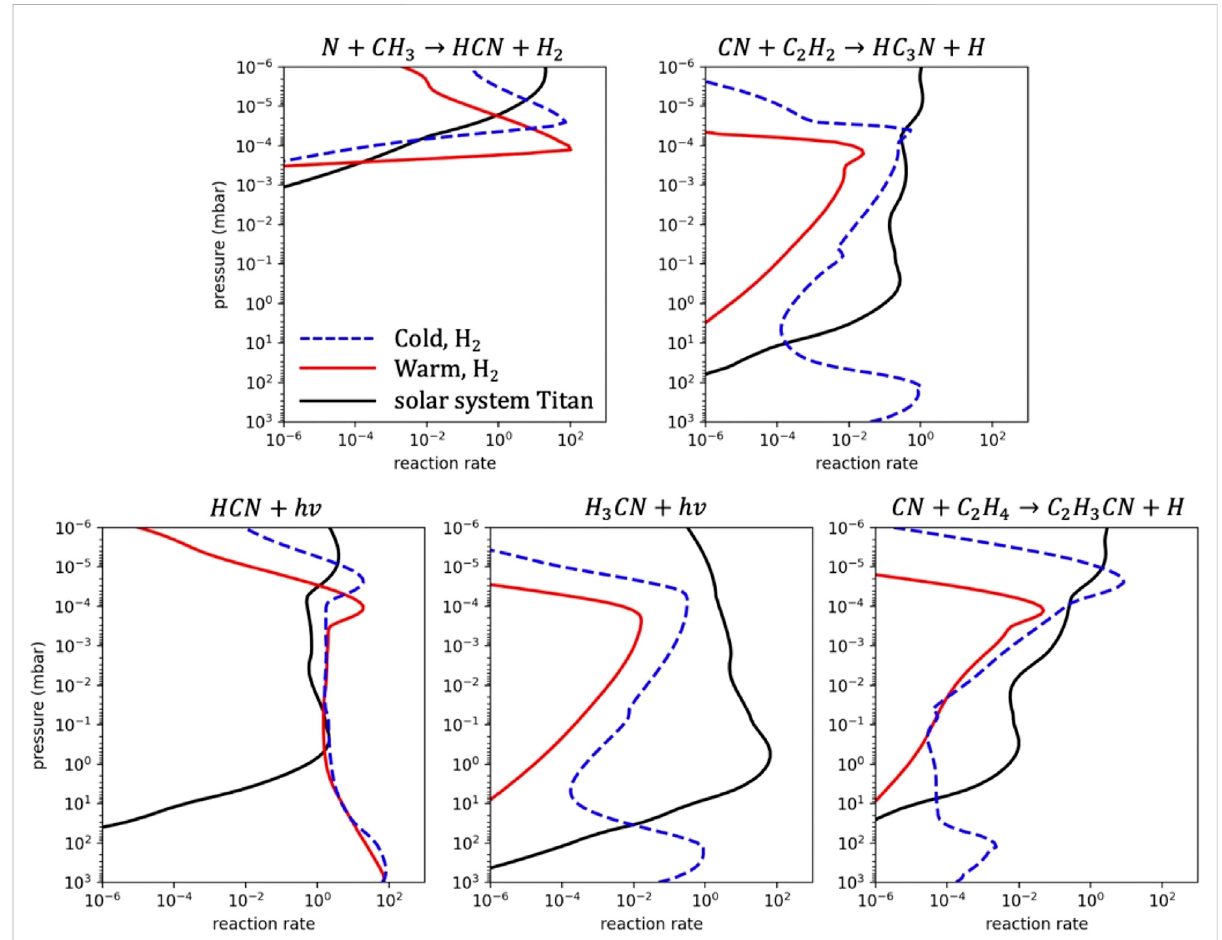
FIGURE 10 Rates (cm − 3 · s − 1 ) of dominant production and loss reactions for -CN species. Black lines represent a cold N 2 atmosphere (Titan), blue lines represent a cold H 2 atmosphere, and red lines represent a warm H 2 atmosphere.